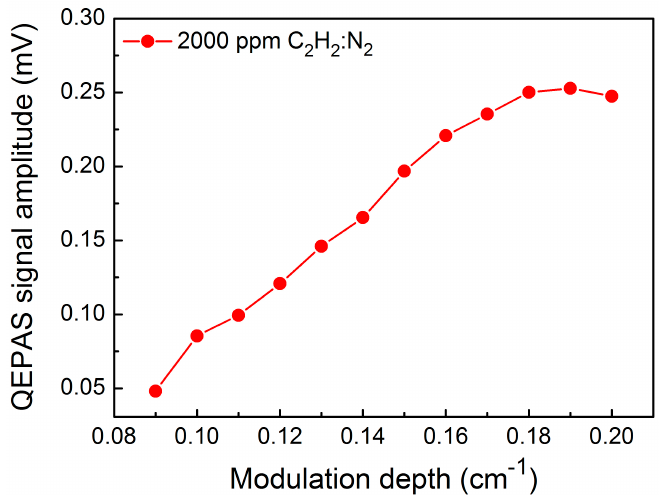
Figure 5. C 2 H 2 -QEPAS signal amplitude as a function of the modulation depth.